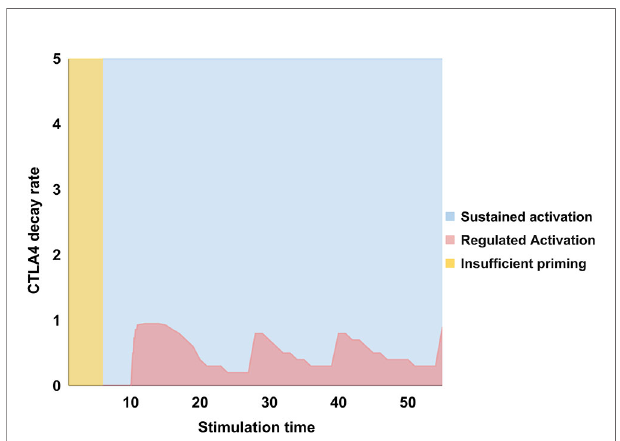
FIGURE 5 | Values of the decay rate of CTLA-4, d CTLA 4 , as a function of the stimulation time, t stim = t CD 8086 = t MHC/A , associated to states of no activation (yellow), sustained activation (blue), or regulated activation (pink). For t stim < 7 units no activation arises; sustained activation ensues for 7 ≤ t stim ≤ 10, and regulated activation for t stim > 10. The fi rst stage implies that a minimum stimulation time is necessary to boost activation; the second one, that CTLA- 4 requires a minimal time of activation to be induced and perform inhibition; the third stage reveals that regulated activation only arises at later stimulation times and when the CTLA-4 decay rate is low, that is, d CTLA 4 < 1. Therefore, CTLA-4 should be induced for a time long enough to overcome a threshold level and its activity should be maintained to perform inhibition. The oscillatory behavior of the regulation threshold is associated to the inhibitory action of CTLA-4 which depends in turn on TCR and CD28 activation. This induces a stimulation-inhibition cycle which is downstream-propagated throughout the network. Consequently, the threshold d CT LA4 leading to regulation is determined by the expression level attained by activation inducers at a given phase of this